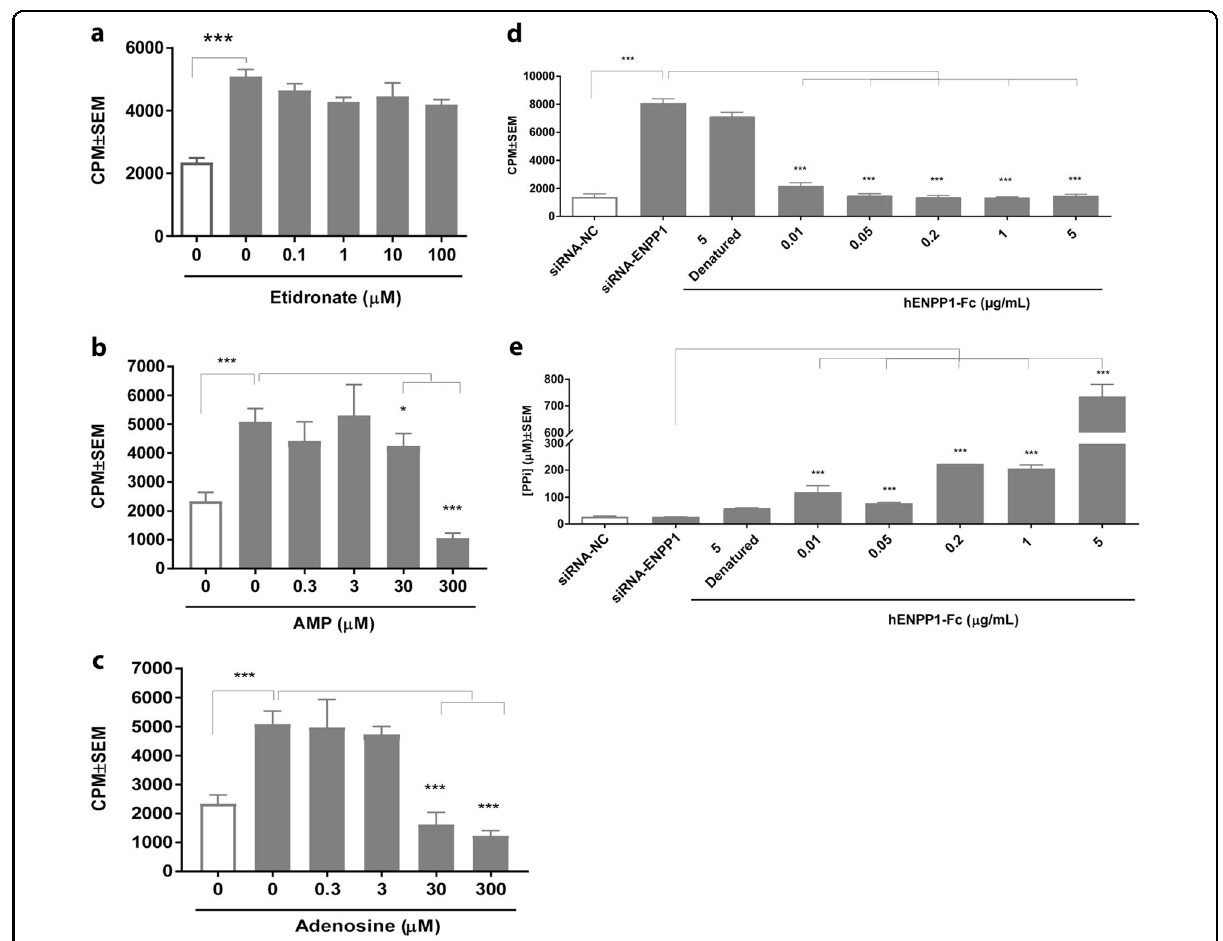
Fig. 3 Effects of bisphosphonates ( a ), AMP ( b ), adenosine ( c ), and rhENPP1-Fc ( d ) on accelerated proliferation in ENPP1 -silenced hiPSC-derived VSMCs. hiPSC-derived VSMCs were transfected overnight with ENPP1 siRNA or control siRNA, followed by 24-h starvation in 0.25% FBS. Then, cells were cultured in basal media, supplemented with etidronate (0.1 – 100 µM, a ), AMP (0.3 – 300 µM, b ), and adenosine (0.3 – 300 µM, c ) for 3 days before determining proliferation. Cell proliferation was evaluated by [ 3 H] thymidine uptake. [ 3 H]thymidine was added in the last 18 h of culture. Extracellular PP i levels in the cell culture medium of cells supplemented with 300 µM ATP and rhENPP1-Fc (0.01 – 5 µg/ml, d ) were determined ( e ). Values are presented as the mean ± SEM, n = 4. *** p < 0.001 (one-way ANOVA multiple group comparison followed by the Bonferroni ’ s post hoc